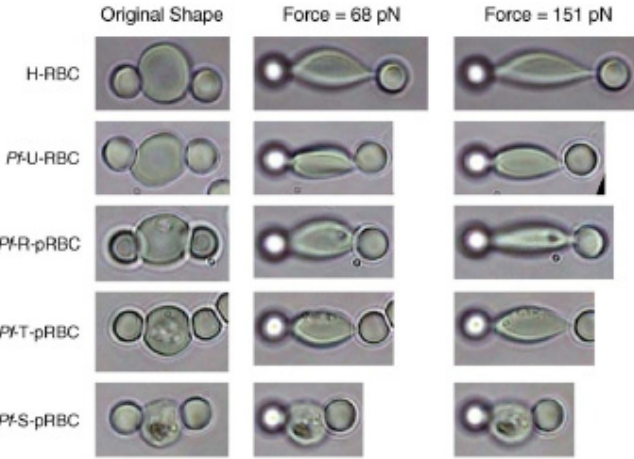
Fig. 2 Images of healthy RBC (H-RBC), uninfected control RBC (Pf-U-RBC), P. falciparum Ring stage parasitized RBC (Pf-R-pRBC), P. falciparum trophozoite stage parasitized RBC (Pf-T-pRBC) and P. falciparum schizont stage parasitized RBC (Pf-S-pRBC) (left column) before stretching, (middle column) stretched at force of about 68 pN (middle column) and stretched at force of about 151 pN (right column). (Reprinted from Suresh et al . (16) with permission from